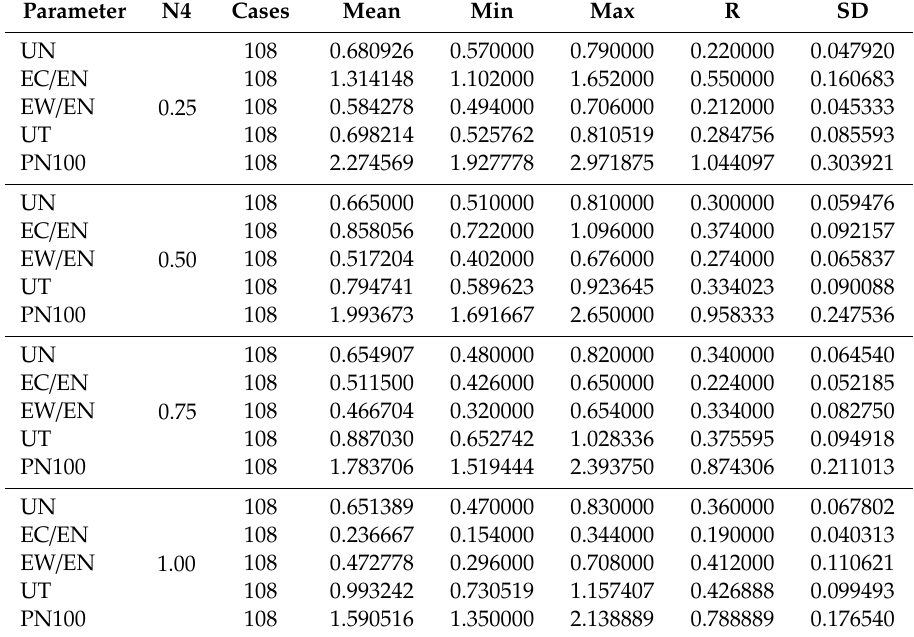
Table 5. Variation of lighting parameters for each lighting class (N4 index).